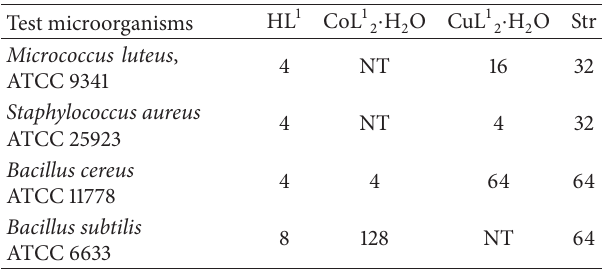
Table 7: Minimum inhibitory concentration of compounds (MIC, 𝜇 g ⋅ mL −1 ). Test